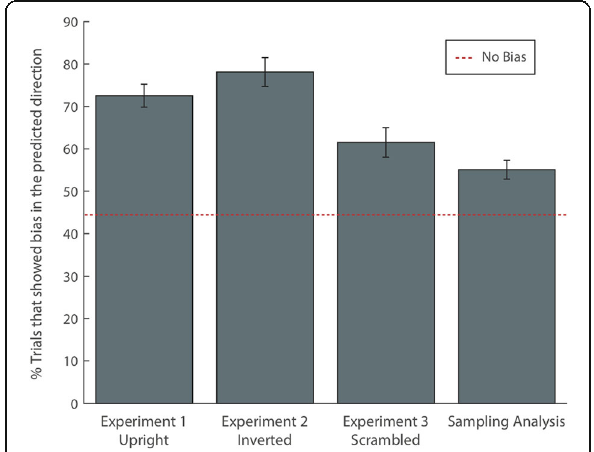
Fig. 2 Percent of trials in which emotional bias was in the expected direction. Bias in the expected direction was calculated by determining the percent of cued image ratings that shifted toward the mean of the distractor image ratings. ‘ No Bias ’ line determined by Monte Carlo simulations. Error bars represent one standard error of the